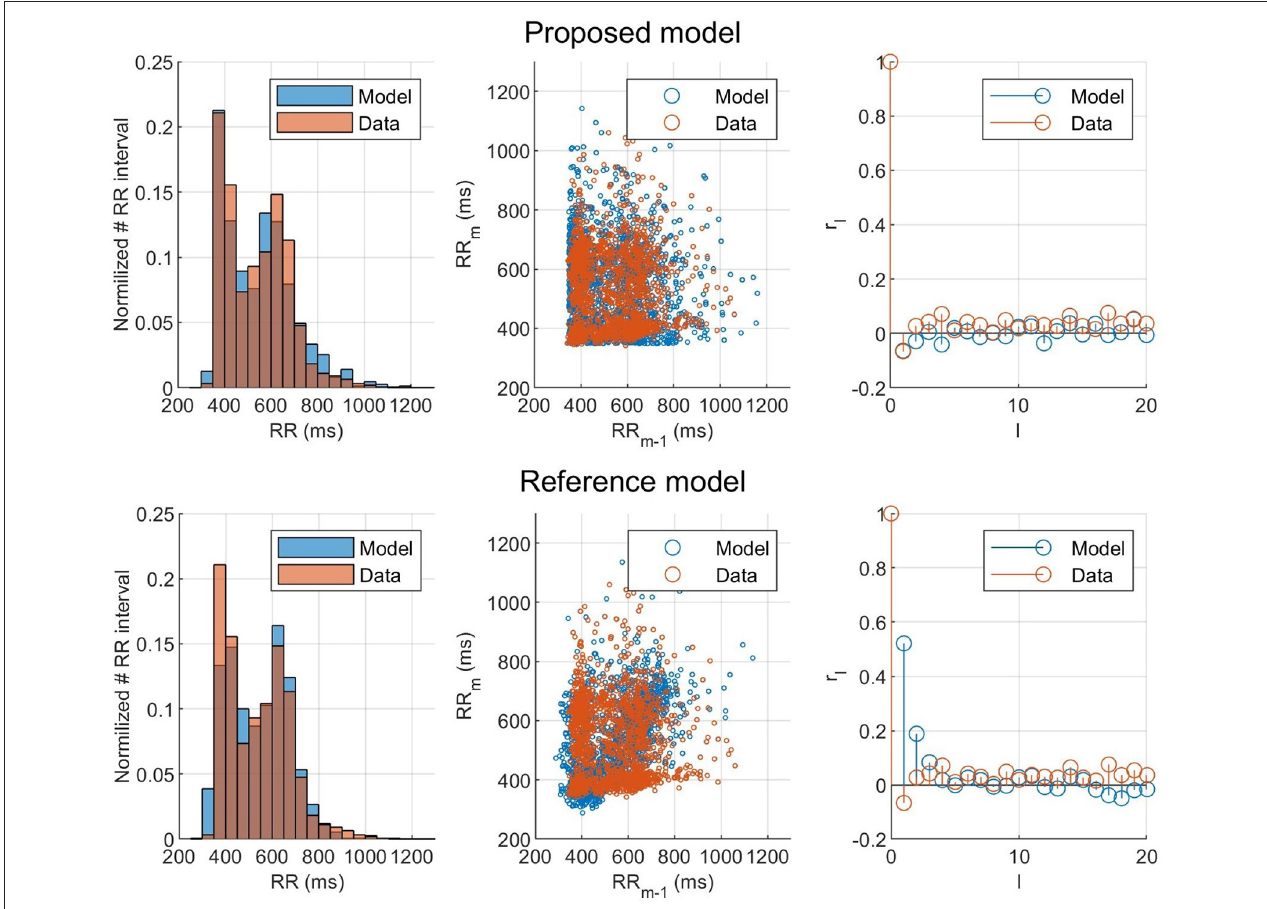
FIGURE 7 | Histogram, Poincaré plot, and autocorrelation representation of the (orange) observed and (blue) modeled RR interval series for (top) the fitted proposed model and (bottom) the fitted reference